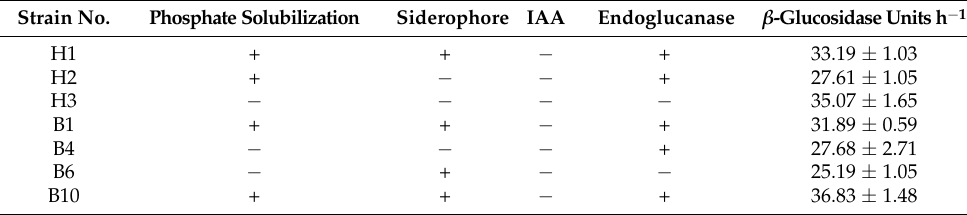
Table 2. Plant-growth-promoting traits, where + indicates possession and—indicates the lack of the trait. Each of the treatments consisted of three biological